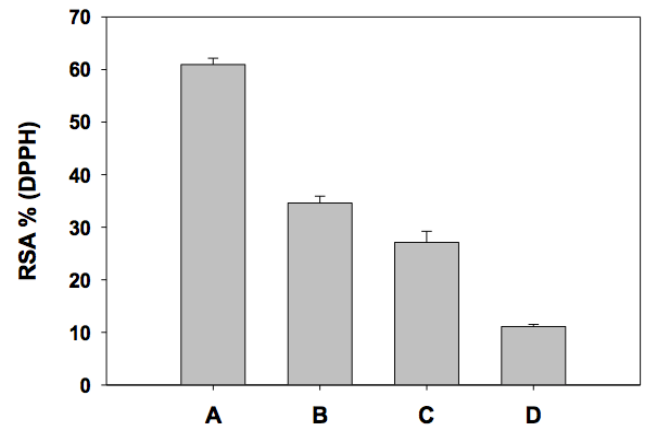
Figure 1. Individual antioxidant capacity of phenolic acids at 0.2 mM. Gallic acid ( A ),